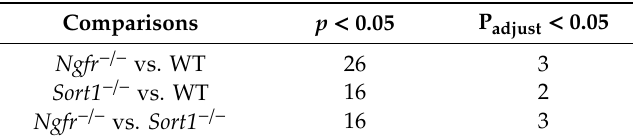
Figure 9. Di ff erentially expressed miRNAs in EVs derived from Ngfr − / − and Sort1 − / − compared with EVs from WT Schwann cells (SCs). ( a ) The 45 most significantly di ff erentially expressed miRNAs (not multiple-testing corrected) are shown as a heatmap covering all samples from WT, Ngfr − / − and Sort1 − / − SCs. Top annotation shows Sort1 − / − in orange, Ngfr − / − in yellow and control WT as blue. Shown are z scores of log2-transformed RPM values. ( b ) Volcano plot for EV miRNAs from Ngfr − / − versus WT comparison and ( c ) Volcano plot for EV miRNAs from Sort1 − / − versus WT. Plotted are –log10( p -values) vs. − log2(fold change). Red means < 0.05 adjusted p -value. Vertical lines indicate +/ − 1 log2(fold change). The names for the 10 most significant miRNA are indicated. Table 6. Numbers of di ff erentially expressed miRNAs with p adjust values below 0.05 or p values (without adjusting for multiple testing) below 0.05.